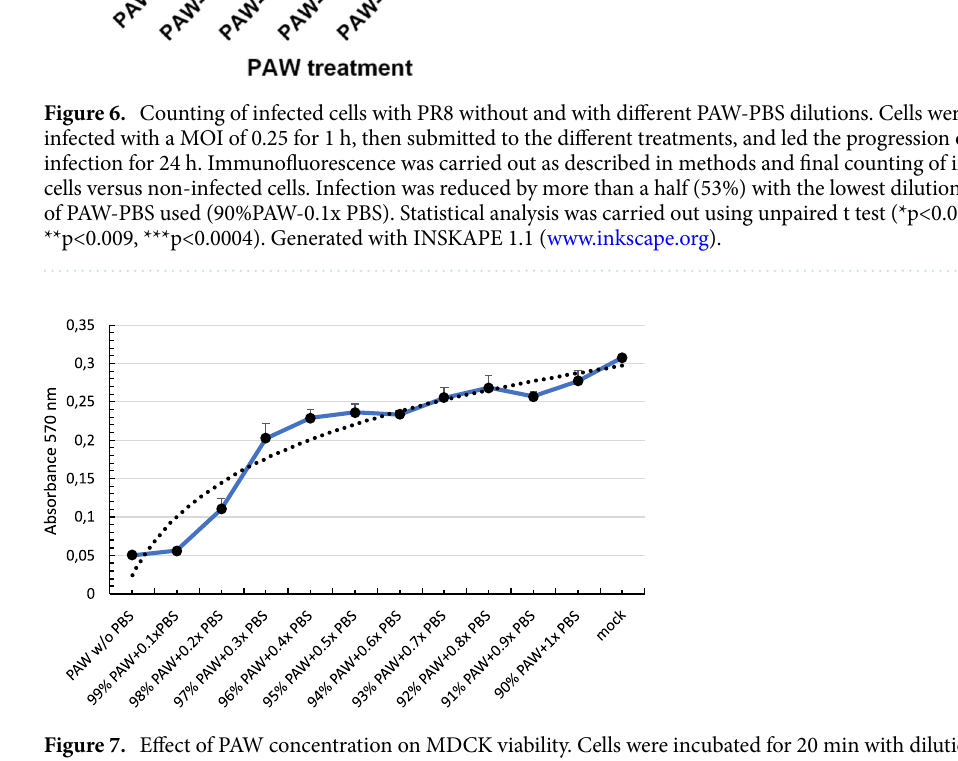
Figure 7. Effect of PAW concentration on MDCK viability. Cells were incubated for 20 min with dilutions of PAW-PBS, ranging from 100% to 90% of pure PAW. Cell viability was determined by MMT assay. Absorbance values were used to calculate an exponential curve fitting and to estimate the concentration of PAW-PBS that causes 50% of citotoxicity (CC50). Generated with INKSCAPE 1.1 (www. inksc ape.